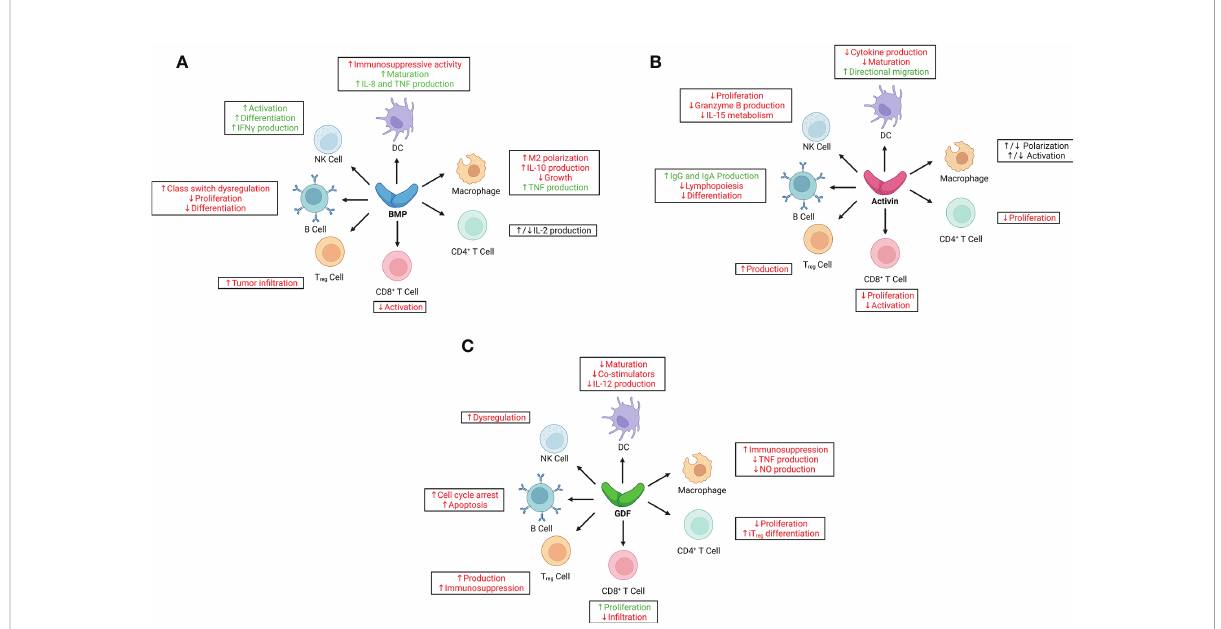
FIGURE 2 Immunoregulatory effects of bone morphogenetic proteins (BMPs), activins, and growth and differentiation factors (GDFs) on key cells of the innate and adaptive immune systems. (A) BMPs have largely pro-in fl ammatory effects in adaptive and innate immune responses, although their immunoregulatory roles in cancer are context-dependent, especially with regard to signaling in natural killer (NK) cells, macrophages, and CD4 + T cells. (B) Activins have predominantly anti-in fl ammatory effects in adaptive and innate immune responses; however, like BMPs, their immunoregulatory function in cancer is largely context-dependent, as evidenced by paradoxical signaling to macrophages and some dendritic cells (DCs). (C) GDFs have broad immunosuppressive effects on both adaptive and innate immune responses, correlating with poor outcomes in various cancer types. Red text indicates pro-tumorigenic effects; green, anti-tumorigenic effects. IFN g , interferon- g ; IL, interleukin; iT reg , induced regulatory T cell; NO, nitric oxide; TNF, tumor necrosis factor; T reg , regulatory T